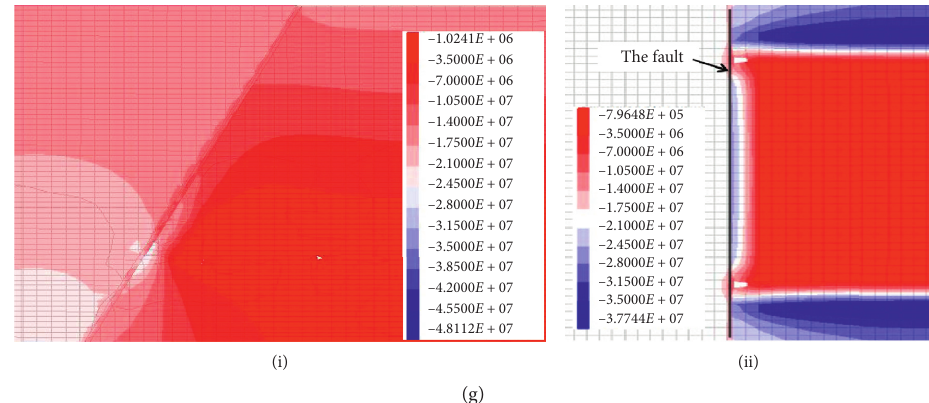
Figure 11: Distribution of the vertical stress at different spacings between the mining face and fault in the footwall. (a) When the working face is 80m away from the fault. (i) Strike at the middle of the working face. (ii) Horizontal direction of the coal seam. (b) When the working face is 50m away from the fault. (i) Strike at the middle of the working face. (ii) Horizontal direction of the coal seam. (c) When the working face is 40 m away from the fault. (i) Strike at the middle of the working face. (ii) Horizontal direction of the coal seam. (d) When the working face is 30m away from the fault. (i) Strike at the middle of the working face. (ii) Horizontal direction of the coal seam. (e) When the working face is 20m away from the fault. (i) Strike at the middle of the working face. (ii) Horizontal direction of the coal seam. (f) When the working face is 10m away from the fault. (i) Strike at the middle of the working face. (ii) Horizontal direction of the coal seam. (g) When the working face is 5m away from the fault. (i) Strike at the middle of the working face. (ii) Horizontal direction of the coal seam.